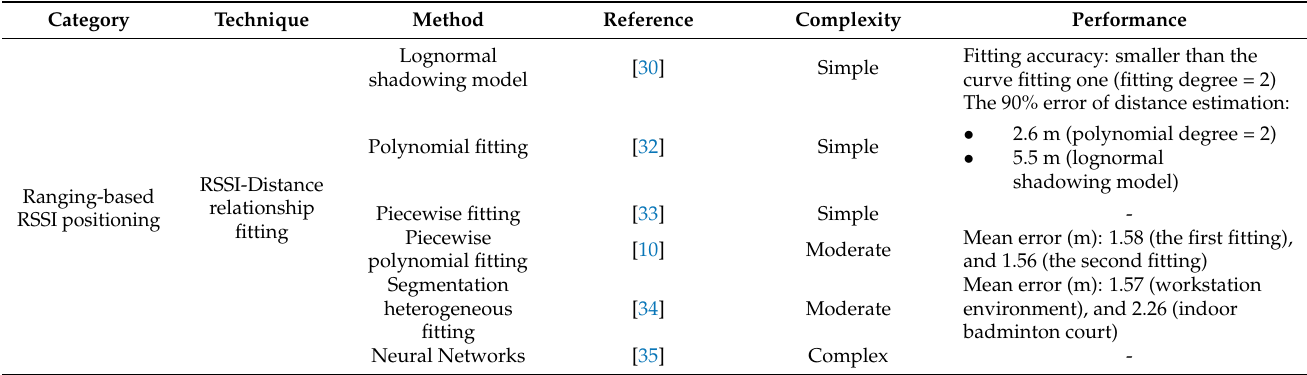
Table 1. Summary of RSSI-based Wi-Fi positioning